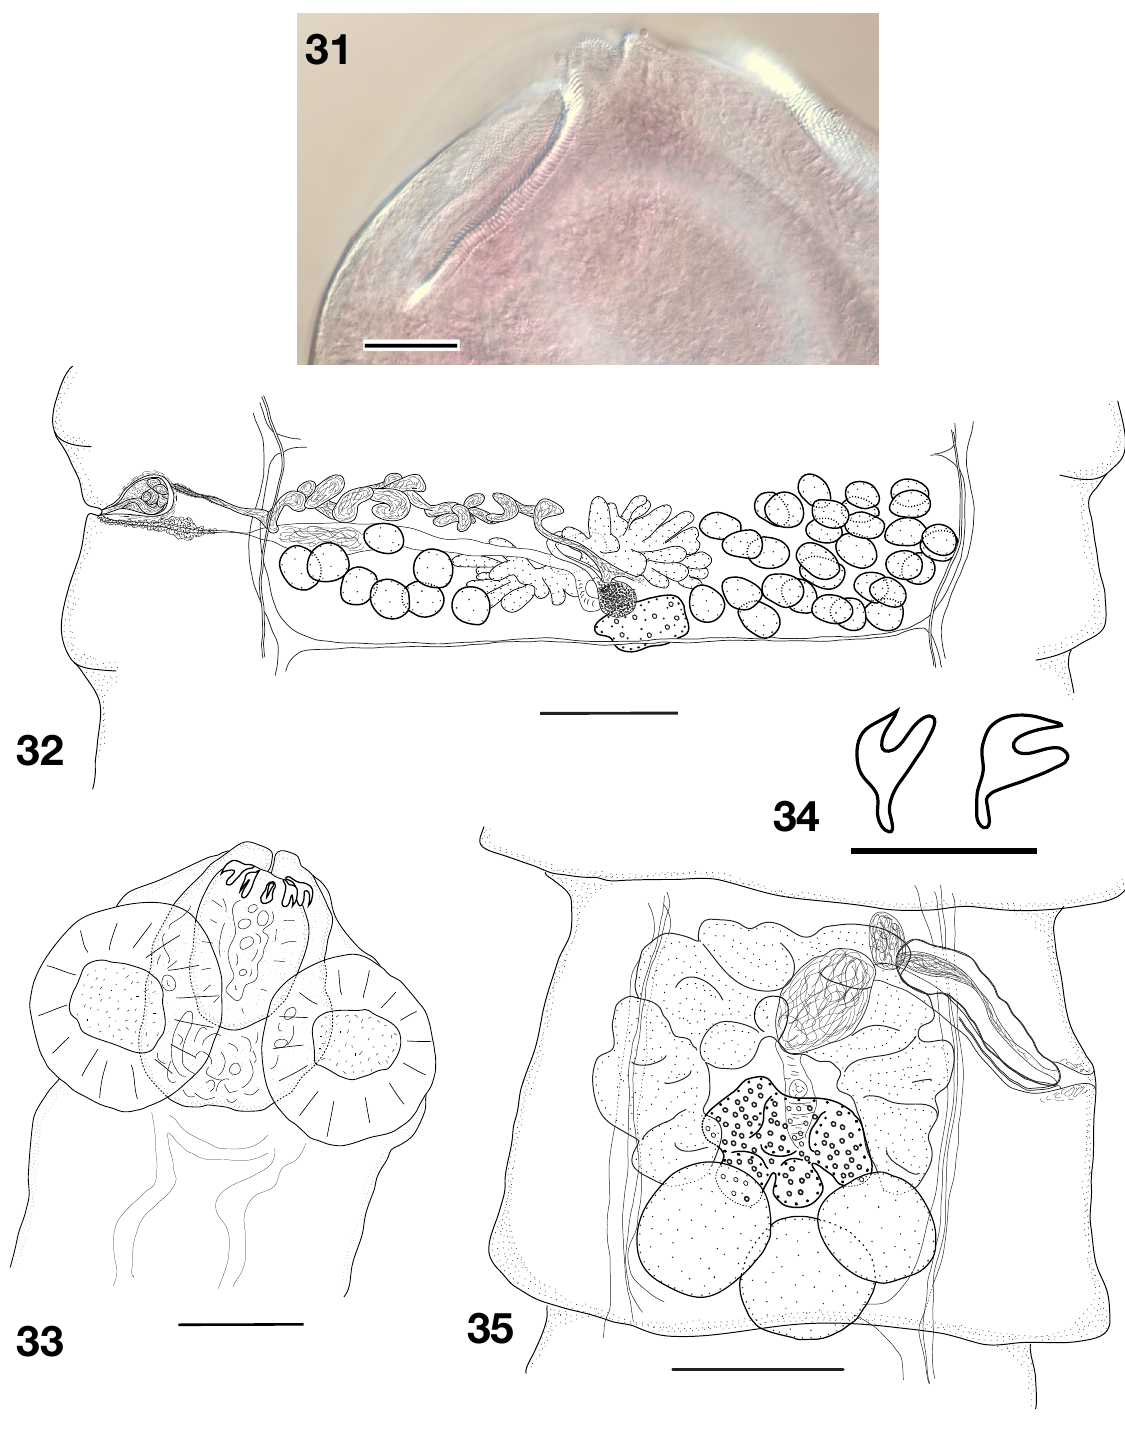
Figs 31–35. — 31–32. Ophryocotlyoides dasi Tandan & Singh, 1964. 31 . Scolex with double crown of hooks, spinuous pseudoproboscis and armed suckers margins. 32 . Mature proglottis, ventral view. — 33–35 . Variolepis cf. bilharzii (Krabbe, 1869). 33 . Scolex. 34 . Rostellar hooks. 35 . Mature proglottis. Scale bars: 31, 33 = 50 µm; 32 = 250 µm; 34 = 20 µm; 35 = 100 µm.